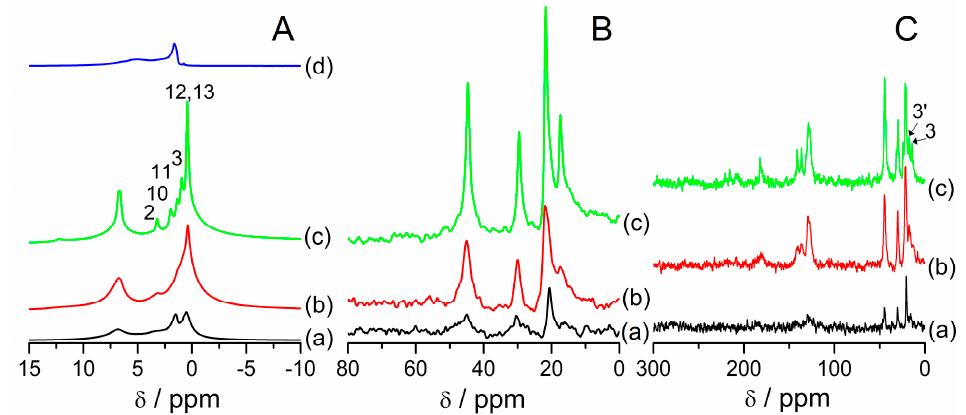
Figure 5. 1 H ( A ), 13 C HPDEC ( B ), and 13 C CP ( C ) MAS NMR spectra of the samples: FAU31–12IBU ( a ), FAU31–24IBU ( b ), FAU31–38IBU ( c ), and FAU31 ( d ) after dehydration in an oven for 19 h in 85 °C. The signals were assigned according to the convention presented in Figure S3 (Supplementary Information). Apostrophes indicate signals from ibuprofen molecules located in mesopores (more details in text).